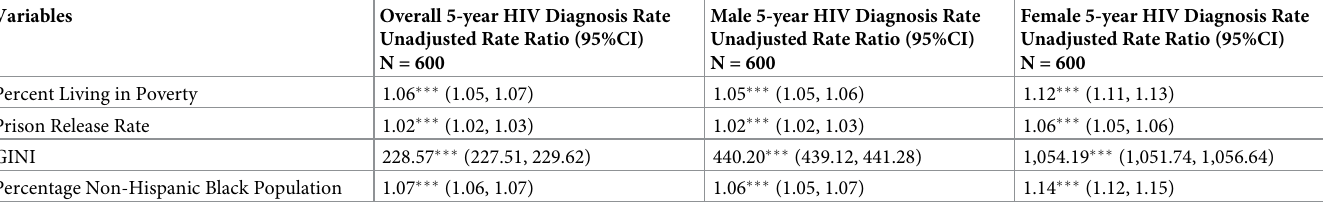
Table 3. Univariate negative binomial regression models of 5-year overall, male and female HIV diagnoses rates.